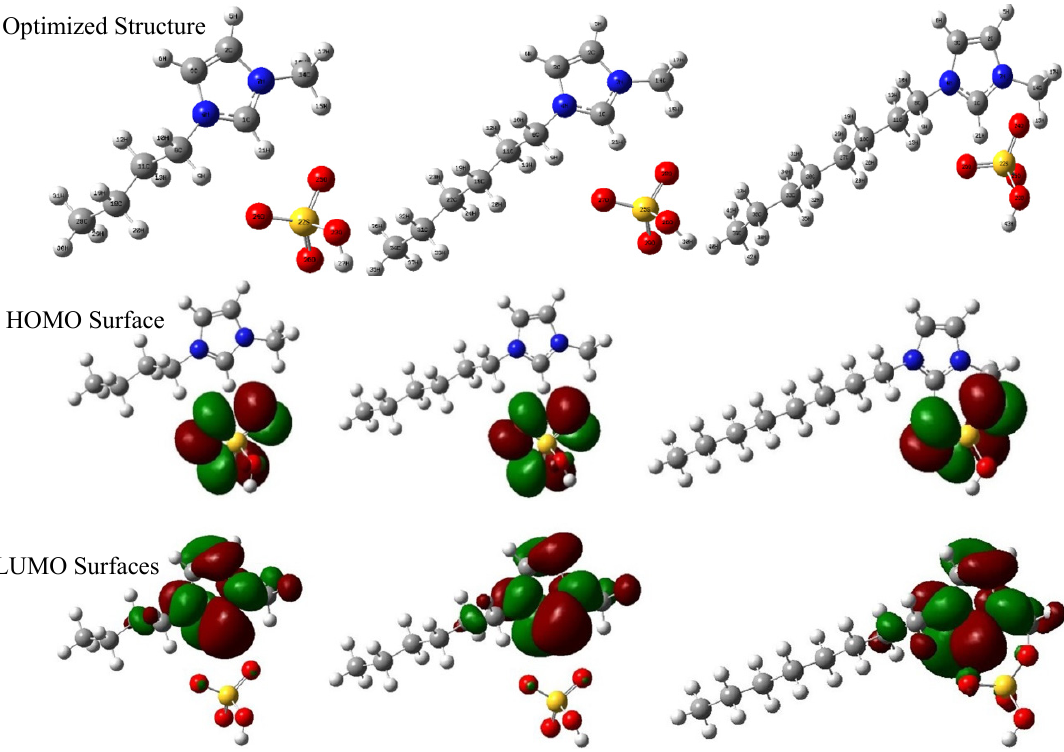
Figure 2. Equilibrium geometry structure, LUMO and HOMO isosurfaces calculated at B3LYP/6-31++G(d,p) for [BMIM]HSO 4 , [HMIM]HSO 4 and [OMIM]HSO 4.